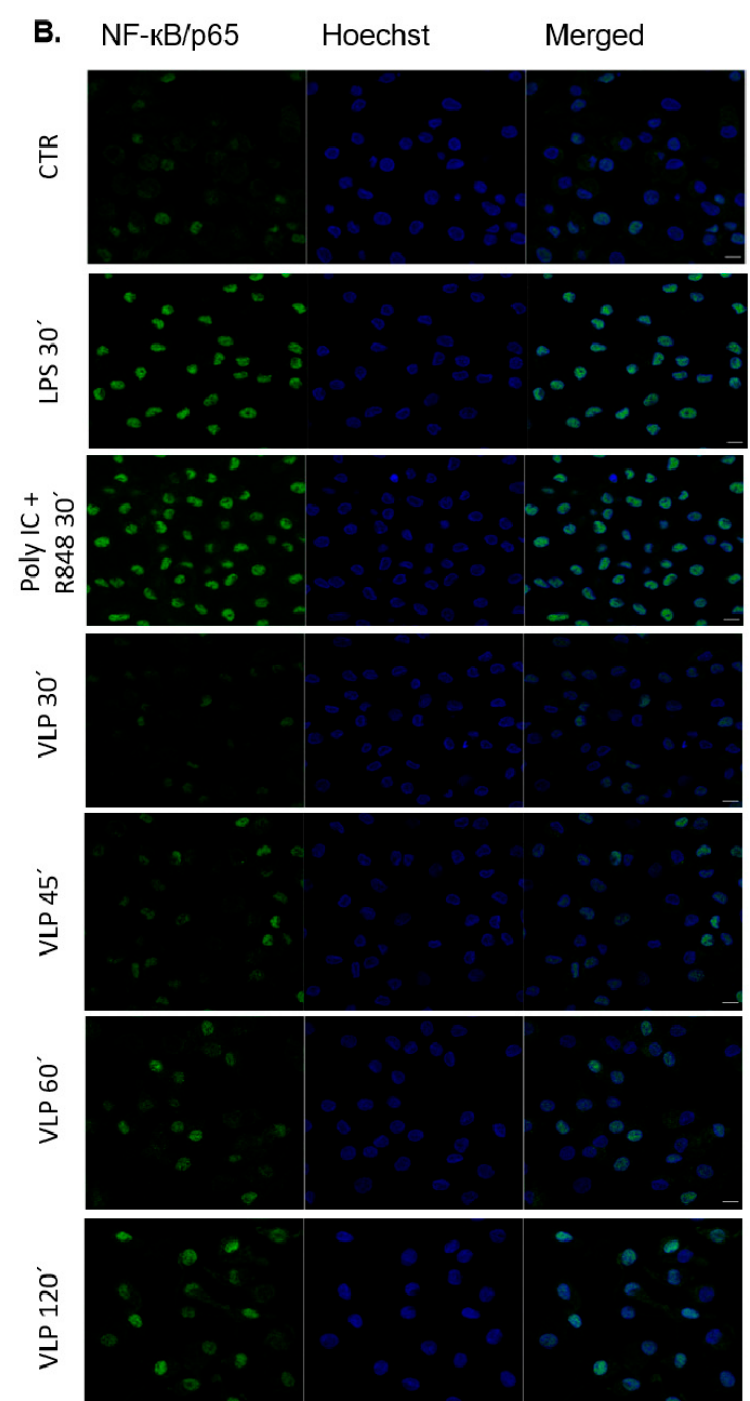
Figure 4. VLPs induce NF- K B nuclear translocation in human DCs. DCs were treated with 20 µ g/mL Poly I:C and 2.5 µ g/mL R848, or 10 µ g/mL VLPs, or VLPs plus 20 µ g/mL Poly I:C and 2.5 µ g/mL for 24 h. ( A ) I K B α levels were evaluated using Western blot. Each column expresses the normalized expression to the control (not stimulated cells) and represents the mean ± SEM of five independent experiments. Representative images are shown. **** p < 0.0001 relative to the CTR. ( B ) Fluorescence staining of the nuclei (blue) and immunofluorescence staining of NF- κ B/p65 (green) were performed as described in Materials and Methods. Control cells (CTR) were not stimulated. Scale bar 10 µ m. Representative images of each condition are shown. LPS: lipopolysaccharide; VLP: virus-like particles, PolyI:C: polyinosinic:polycytidylic acid, R848: resiquimod. Taken together, these results indicate that Poly I:C and R848 and, to a lesser extent, VLPs, trigger the NF- κ B pathway, which is well correlated with the increased expression of the maturation surface markers on DCs and the release of proinflammatory cytokines.